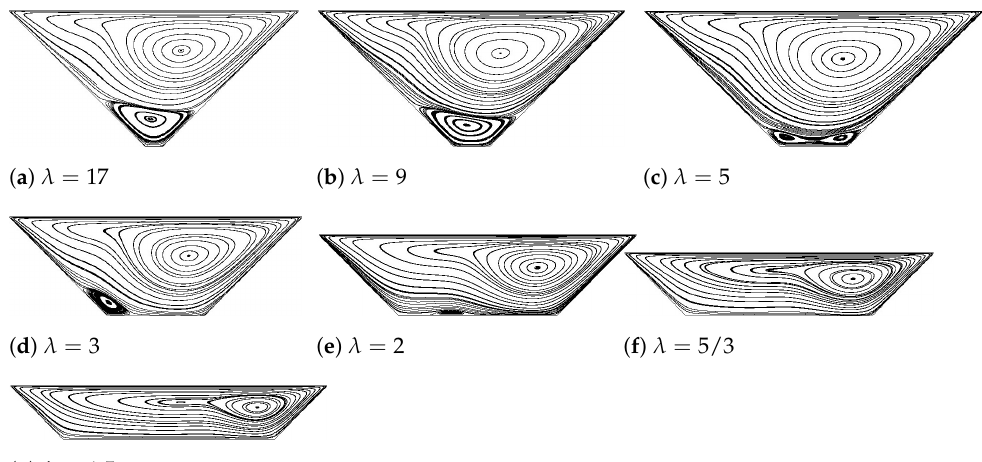
Figure 7. Streamlines inside the bowl-shaped trapezoid with various values of λ at Re = 1000.